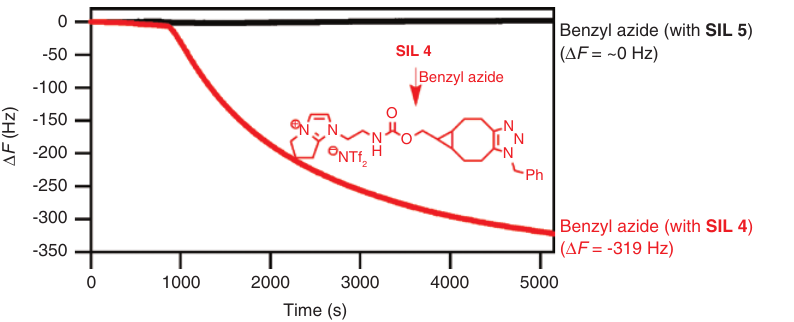
Figure 4: Chemoselective detection of benzyl azide gas (146 ppb) by 9 MHz QCM thin coated with SIL 4 and SIL 5 (3.3 nl each, 300 nm thickness). Nitrogen was used as the carrier gas with a flow rate of 3 ml/min and gas samples were injected at 1000 s. The resonance frequency drop ( Δ F ) is the QCM response on the quartz chip